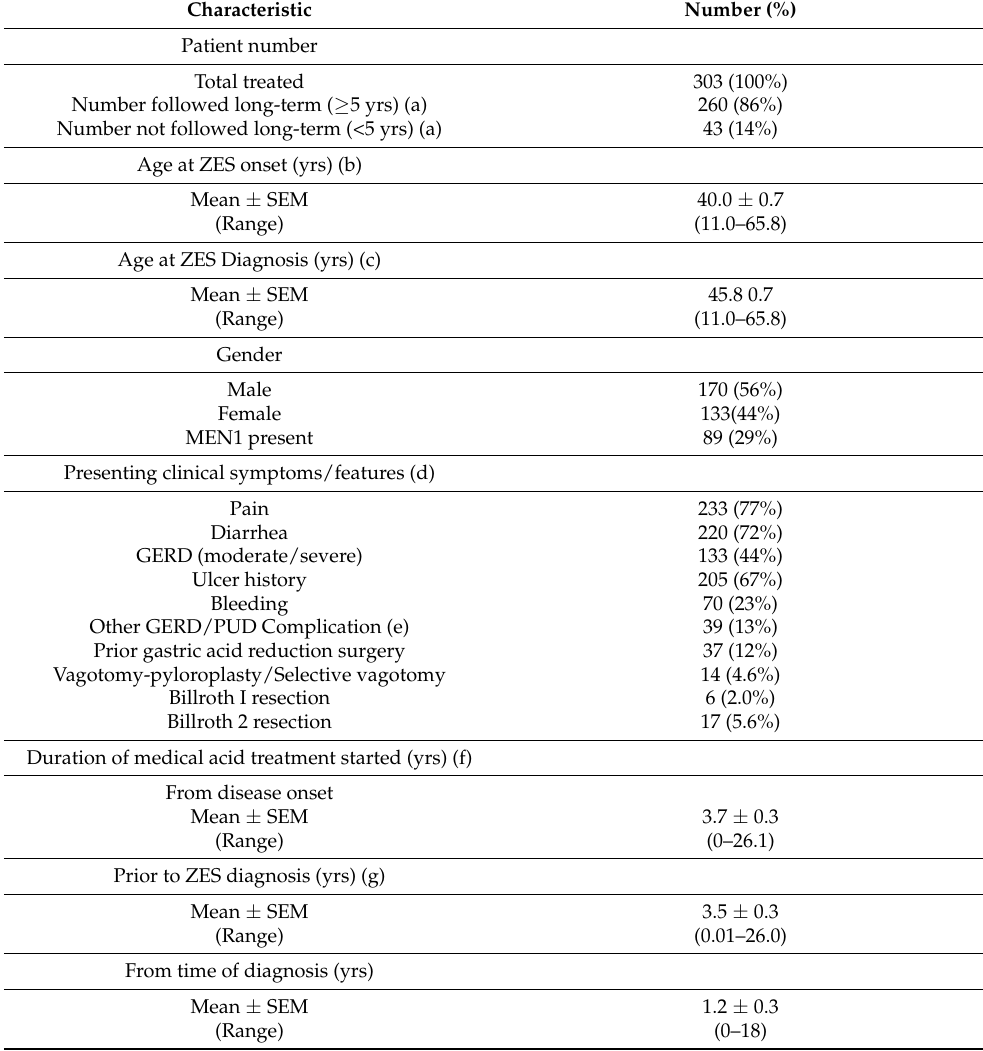
Table 1. Patient clinical